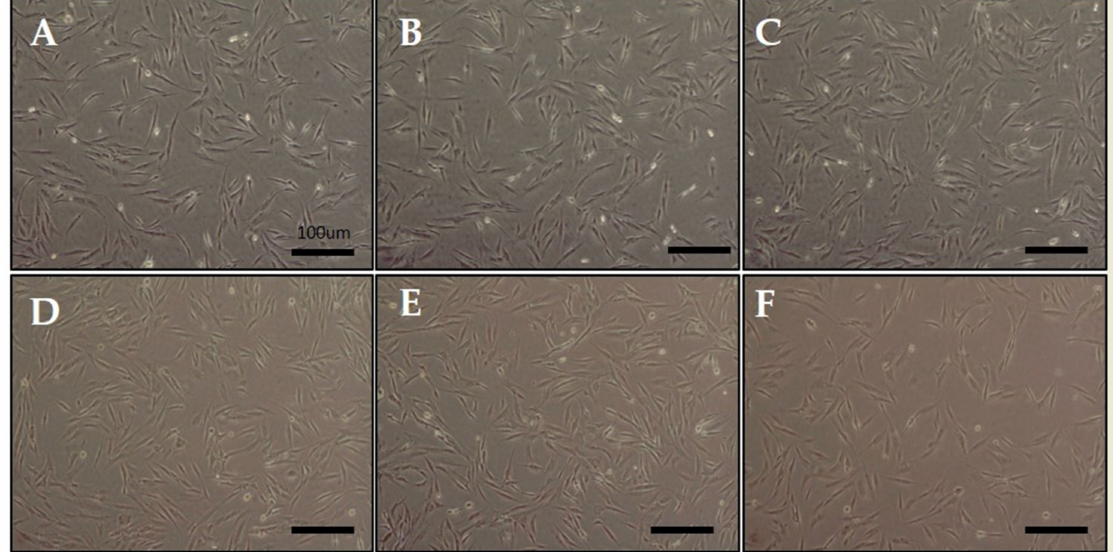
Figure 1. Morphology of human hair follicle dermal papilla cells (hDPCs) after being stimulated by an extremely low-frequency electromagnetic field (ELF-EMF). ( A ) control; ( B ) 5 Gauss (G); ( C ) 10 G;